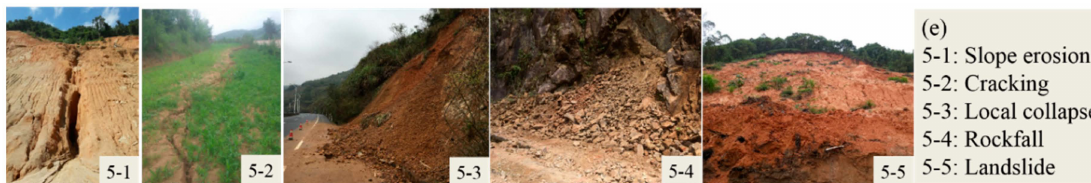
Figure 2. Subgrade distresses in the test sites: ( a ) road shoulder; ( b ) drainage facilities; ( c ) reinforced structure; ( d ) embankment and roadbed; and ( e ) slope.